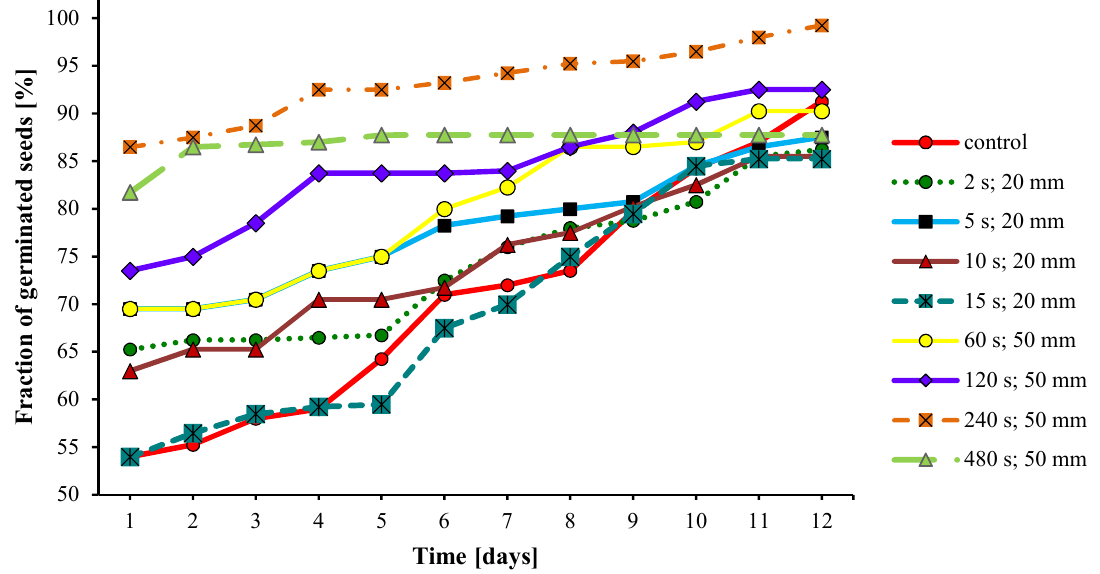
Figure 3. Fraction of germinated onion seeds after pre-sowing plasma treatment. (SD mean: control—2.44 2 s; 20 mm—2.02 5 s; 20 mm—1.86 10 s; 20 mm—1.38 15 s; 20 mm—1.98 60 s; 50 mm—2.02 120 s; 50 mm—1.95 240 s; 50 mm—1.57 480 s; 50 mm—2.32).